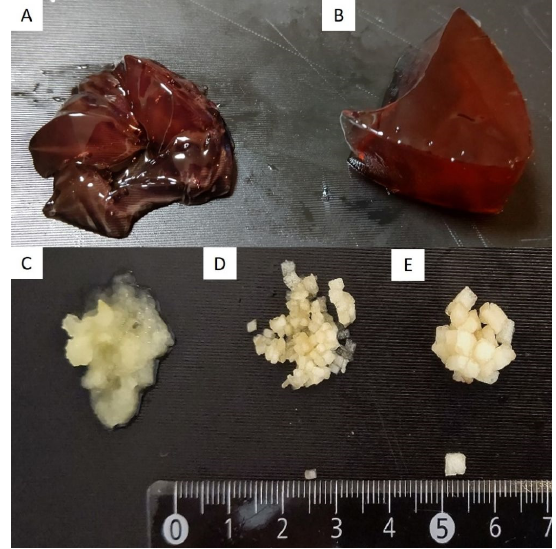
Figure 3. Four types of simulated residues to be suctioned. ( A ) Soft jelly made of agar. ( B ) Hard jelly made of konnyaku. ( C ) Grated apple. ( D ) 1 mm 2 apple pieces. ( E ) 3 mm 2 apple pieces.